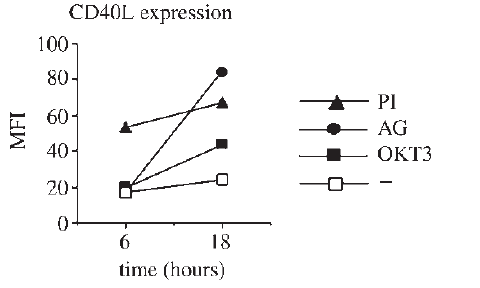
FIGURE 4 Anergic CD4 þ T cells show impaired expression of CD40L. 2 £ 10 5 cells of F17 clone were either untreated ( 2 ) or anergized with immobilized OKT3 (OKT3) or stimulated with 3 £ 10 5 HLA- DRB1*1101 þ B-LCL pre-pulsed o.n. with 10 m g/ml of HA307-19 (Ag) or with PMA þ I (PI) in 48-well plates. Cells were cultured at 37 8 C and CD40L expression was assessed by staining with PE-conjugated anti- human CD40L mAb (TRAP-1). The results are expressed as mean of fluorescence intensity (MFI) measured by FACS and derived from one of four separate experiments.